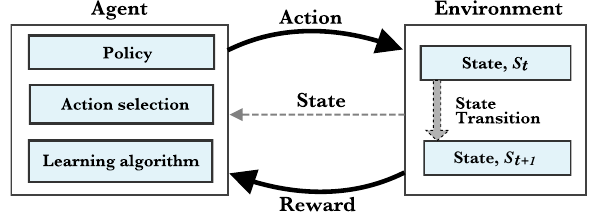
Figure 2. Agent-Environment interactions in the